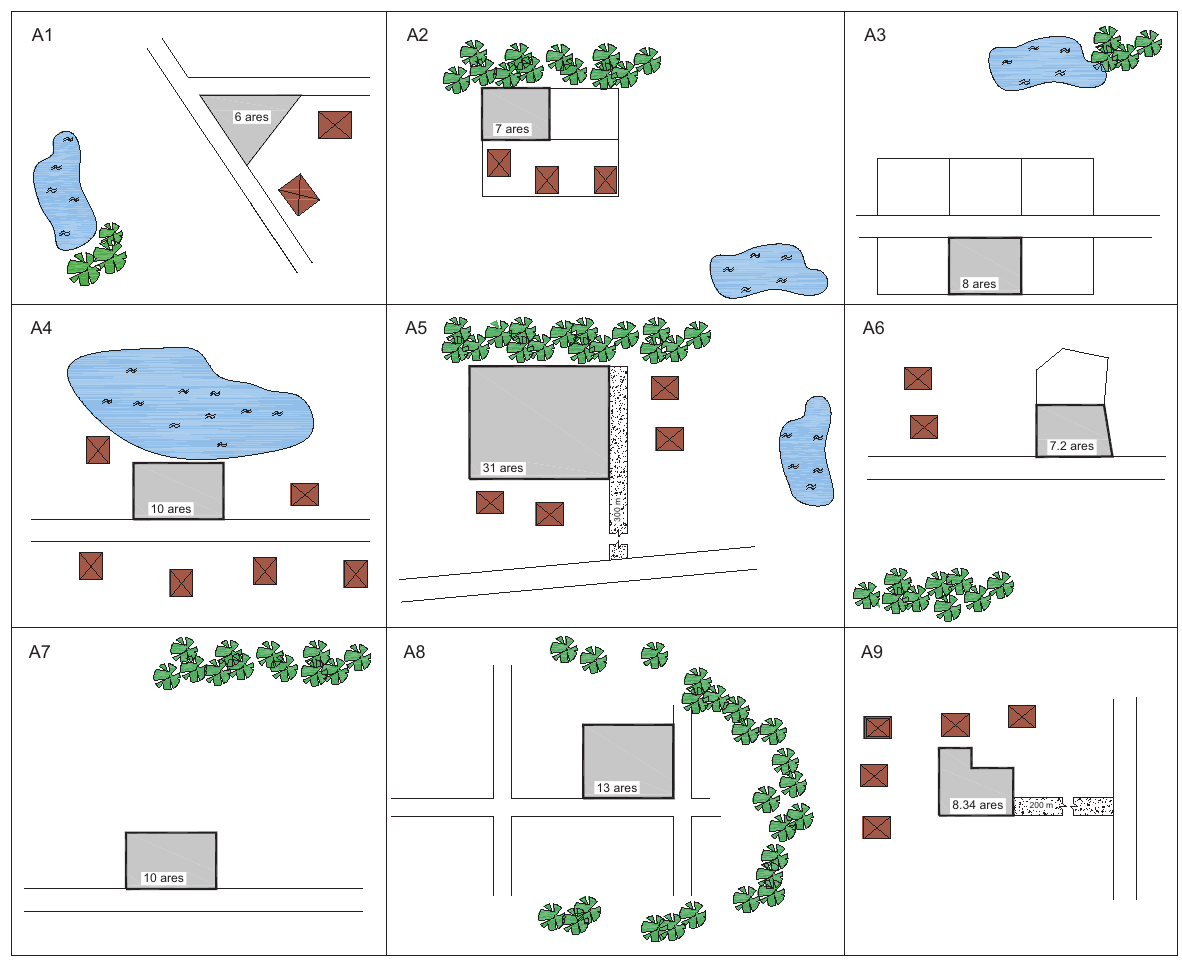
Figure 2. Schemes of alternatives